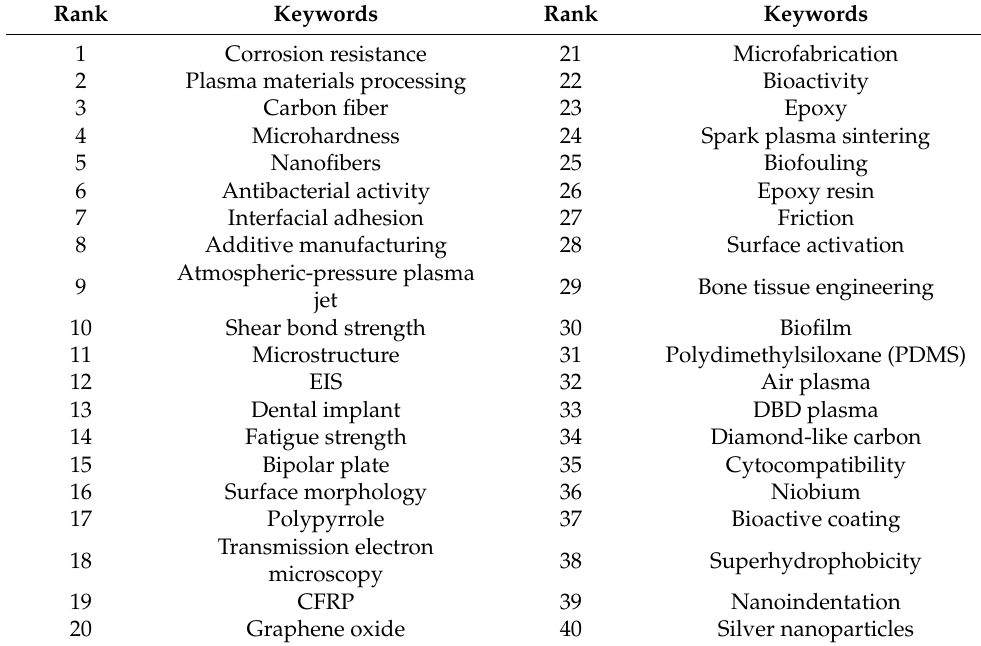
Table 1. Top 40 keywords based on novelty and fast growth related to plasma surface treatment. Rank